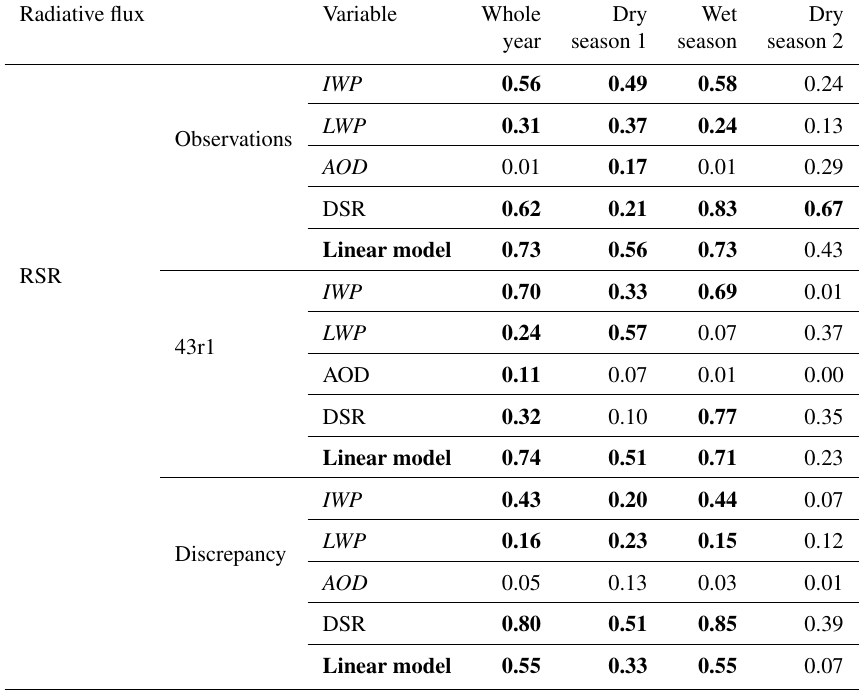
Table 7. TOA RSR fluxes: r 2 values from correlations between observed and 43r1 RSR, and their discrepancy, to other variables for the significant (to p ≤ 0.001) values are in bold. Italics indicate which variables were used in the linear model. Radiative